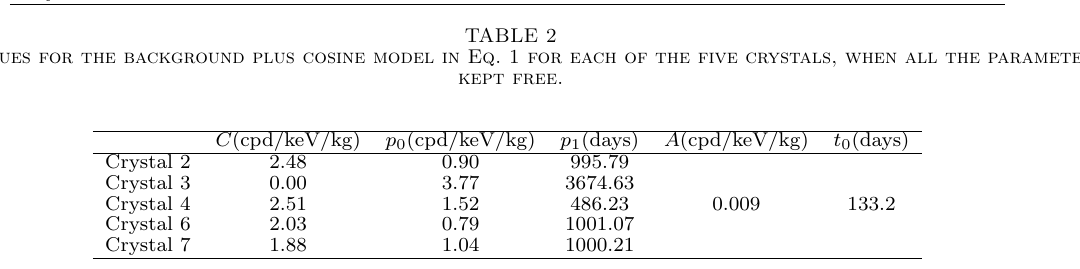
TABLE 3 Best-fit values for the background plus cosine model in Eq. 1 for each of the five crystals, keeping the parameter ω fixed at 0 . 0172 radians/day corresponding to a period of one